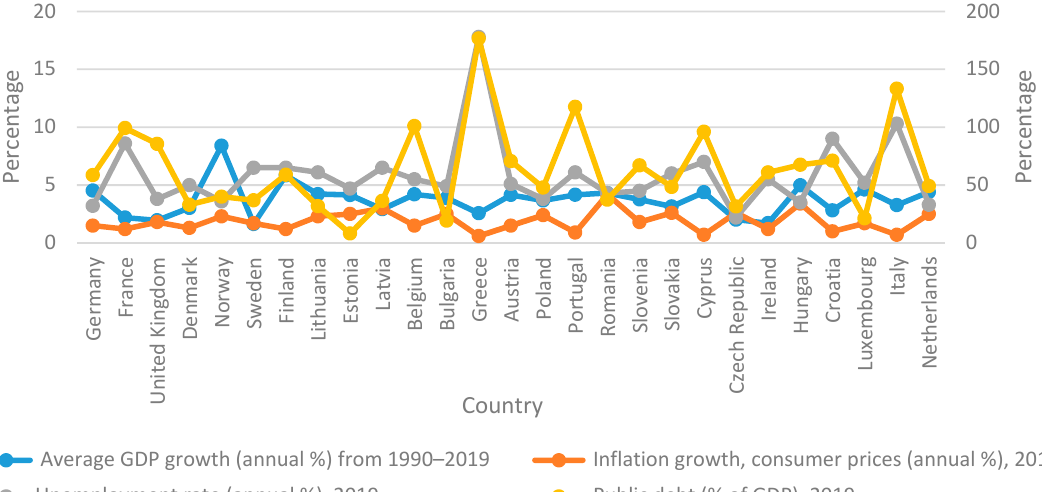
Figure 4. Average GDP growth, 1990–2019, unemployment rate, 2019, inflation growth, 2019, and public debt, 2019, values in analysed countries.